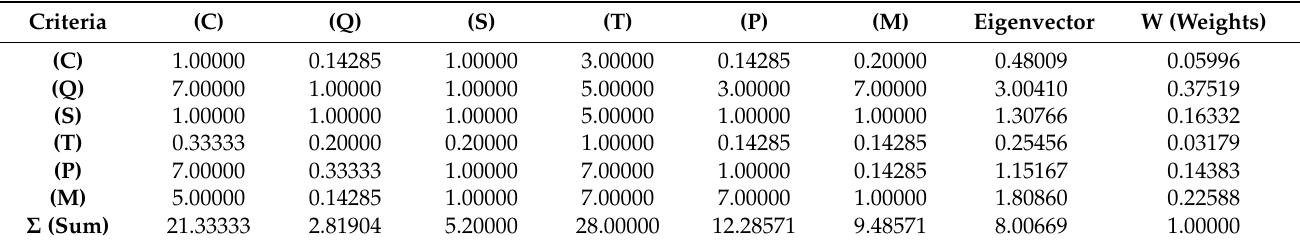
Table 5. Judgment matrix (SCM director).